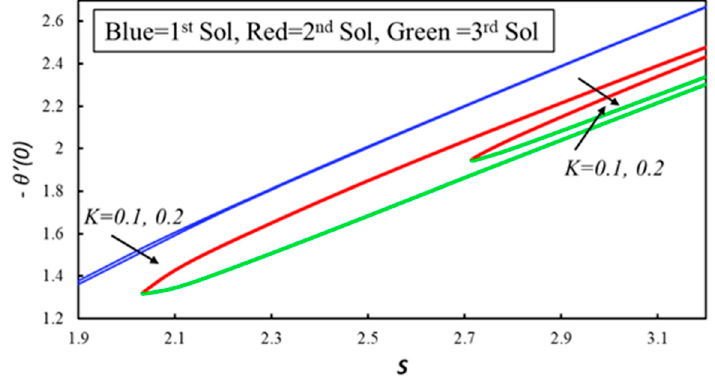
Figure 17. Heat transfer rate with various values of S .